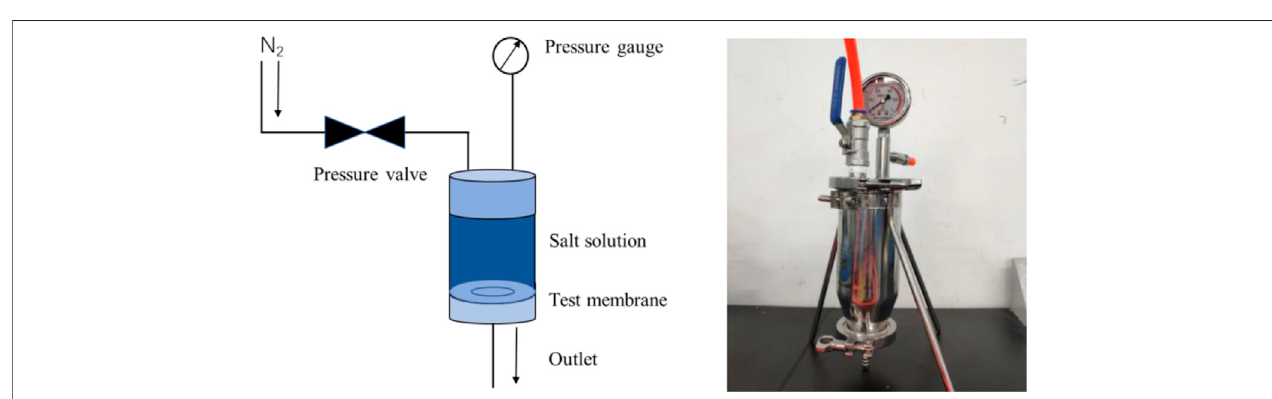
FIGURE 2 | Schematic diagram (A) and physical photo (B) of positive pressure driven fi ltration experimental device.